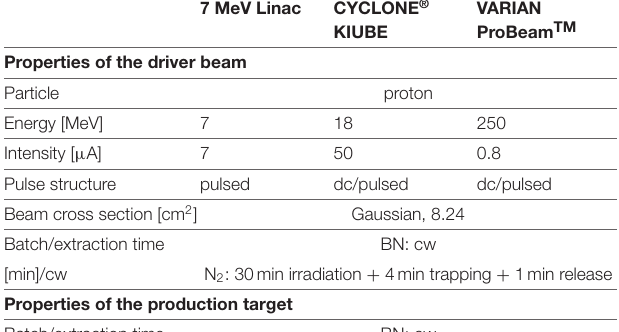
TABLE 2 | Summary of the selected properties (driver beam and of the production target) and comparison of in-target production yields for different driver-target